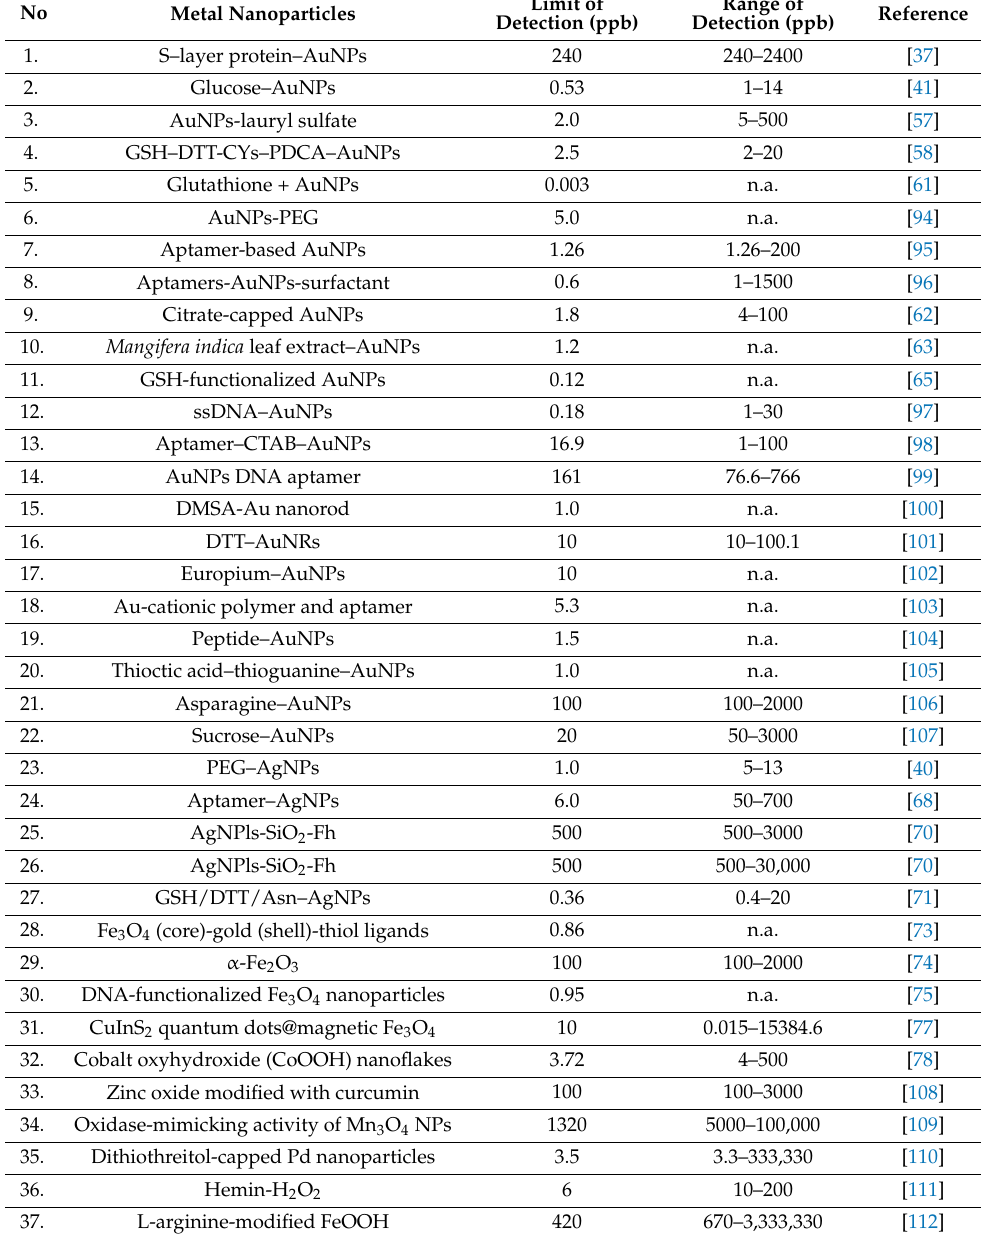
Table 1. The LOD of arsenic (III) using various nanoparticles and a colorimetric